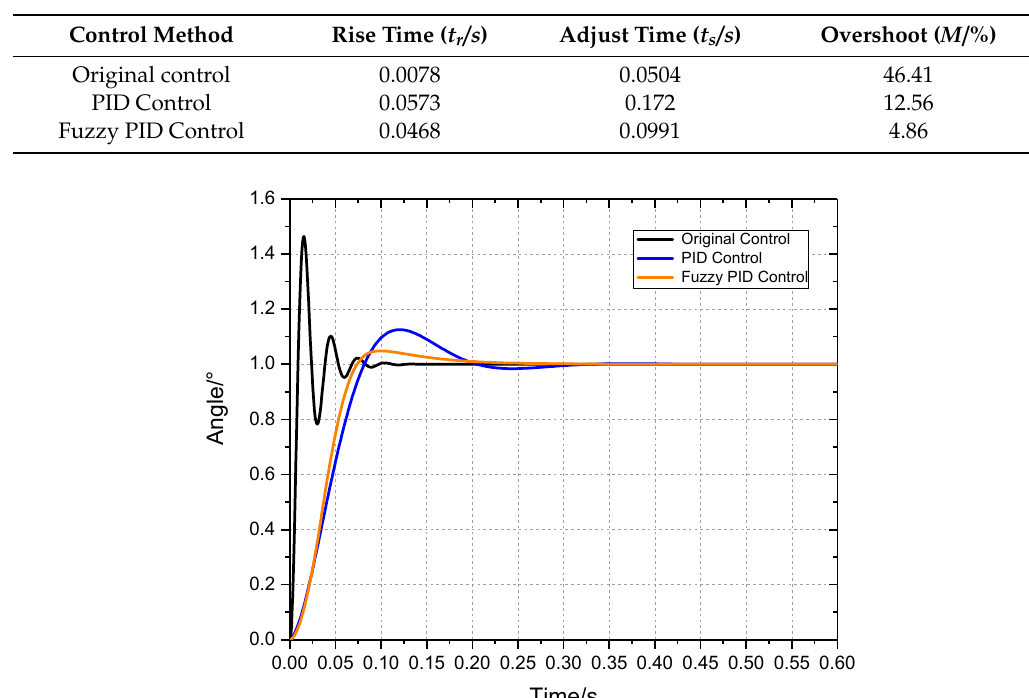
Table 5. Fuzzy PID control simulation data.